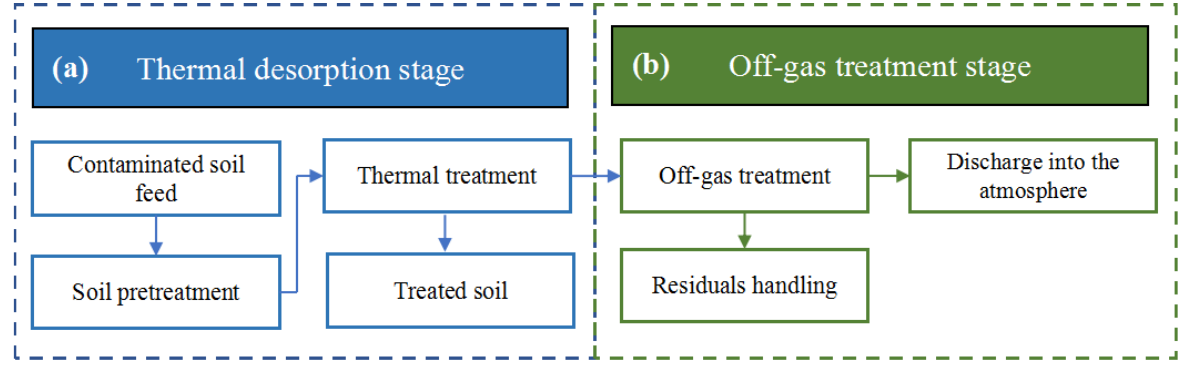
Figure 2. Basic process of a thermal desorption system.